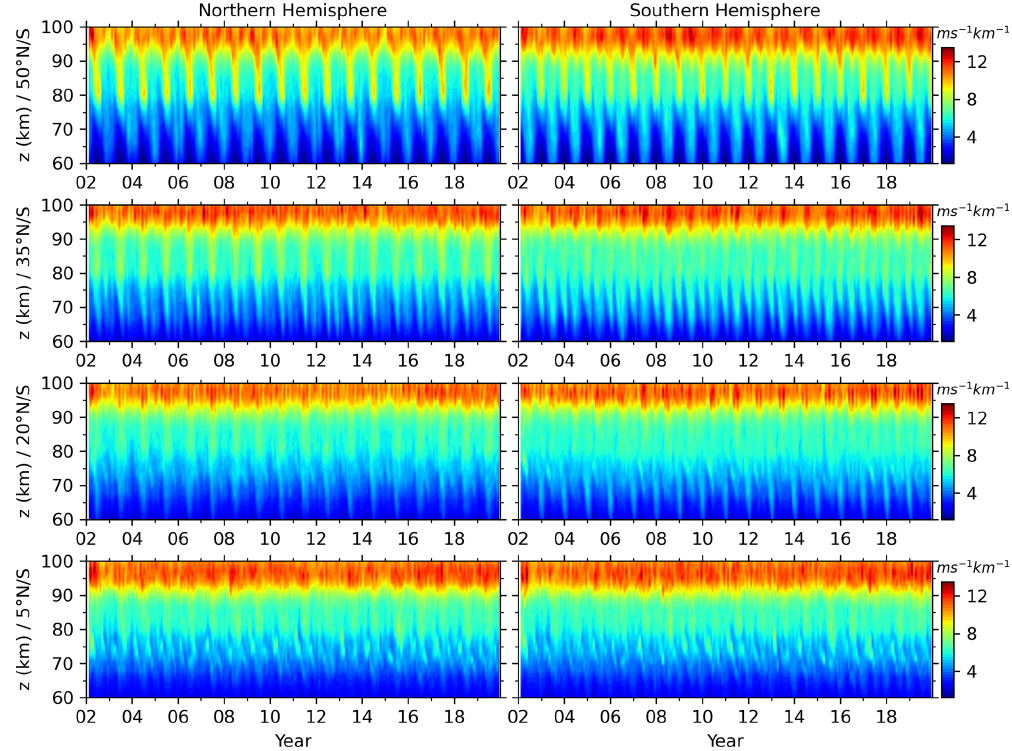
Figure 17. Same as Fig. 9 but for the GW-perturbed shears derived under the medium-frequency assumption f/ ˆ ω j =